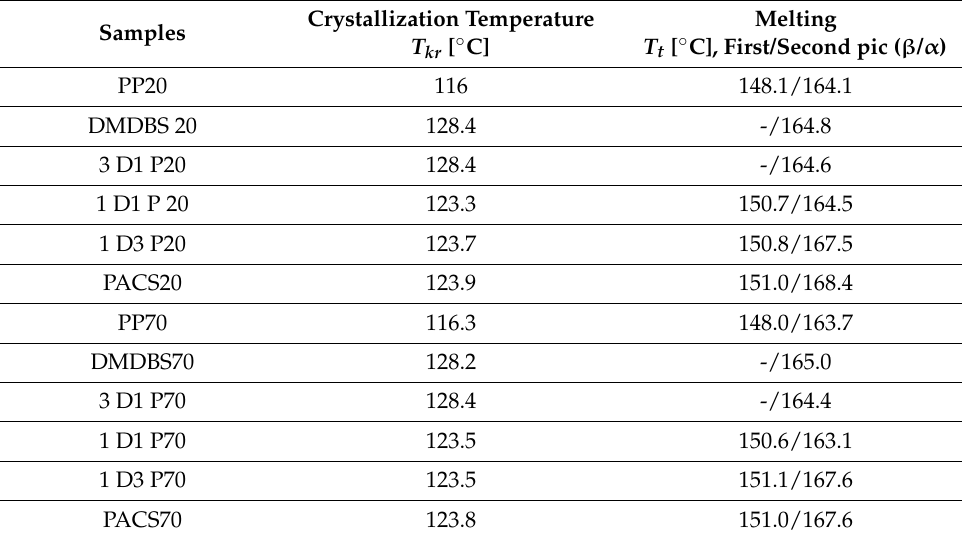
Table 3. The melting and crystallization temperature characteristic for both iPP crystal